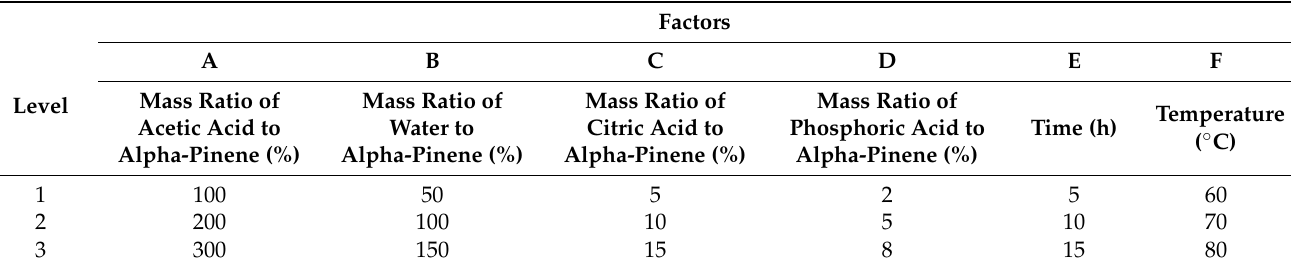
Table 9. Orthogonal experiment design